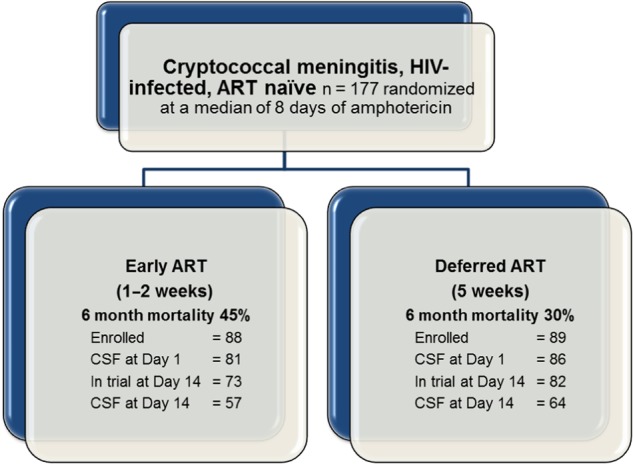
Summary of participants and cerebrospinal fluid (CSF) sampling in the Cryptococcal Optimal ART Timing (COAT) trial. Abbreviations: ART, antiretroviral therapy; HIV, human immunodeficiency virus.